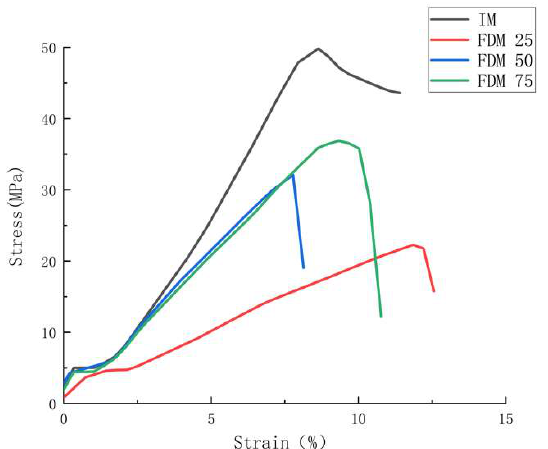
Figure 6. Representative stress-strain curves for tensile test amongst FDM and IM batches.